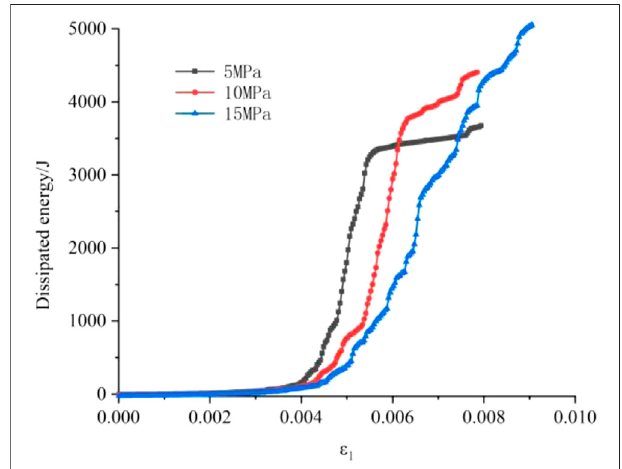
FIGURE 7 | Variation of dissipation energy with strain under different con fi ning